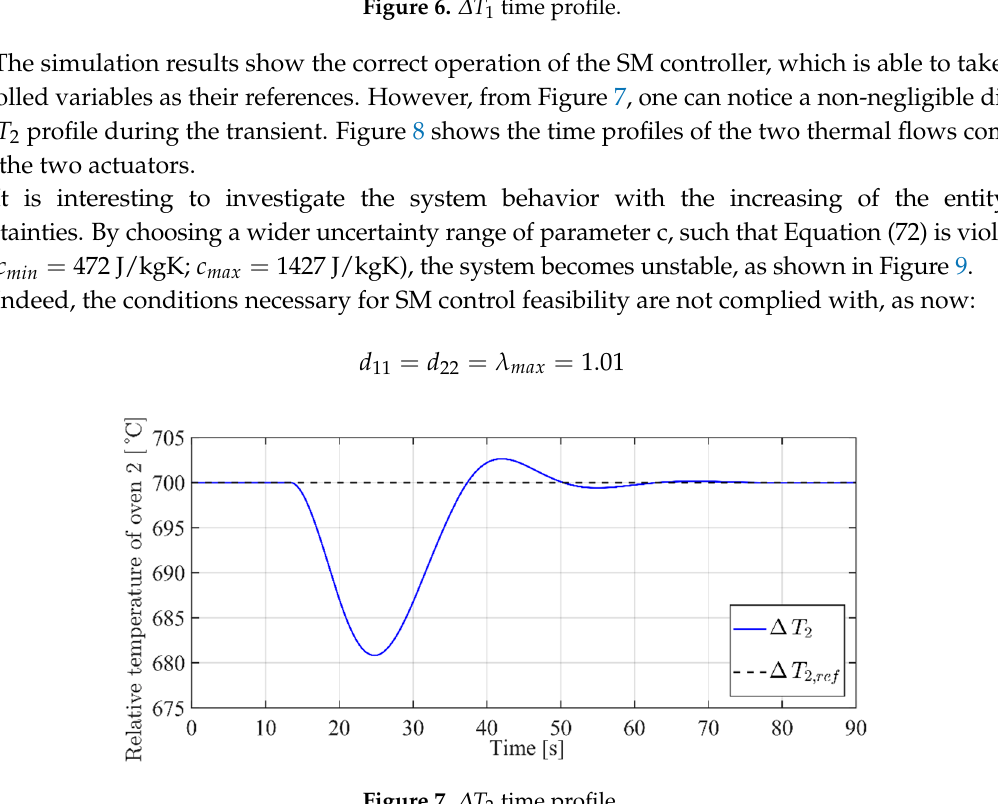
Figure 7 𝛥𝑇 (cid:2870) time profile. Figure 7. ∆ T 2 time